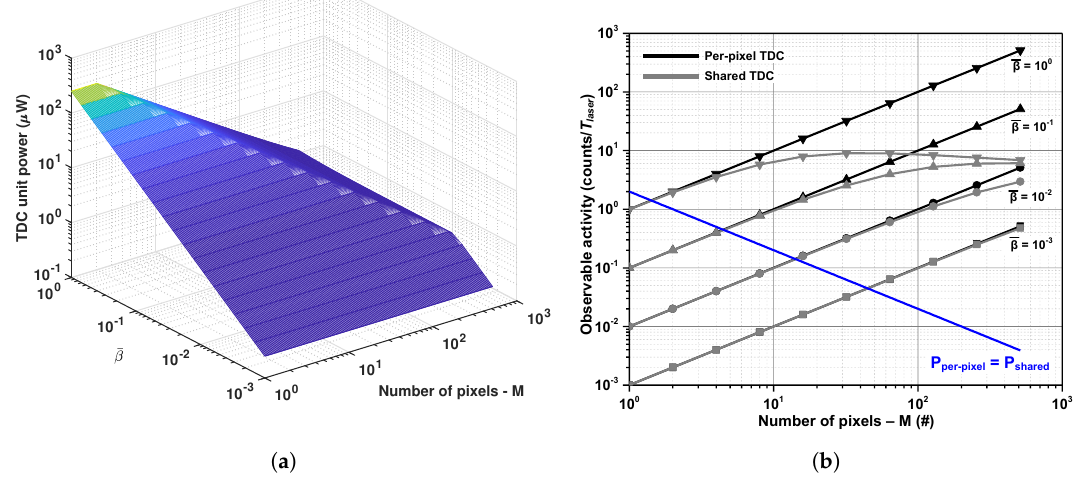
Figure 3. Relationship between power consumption, activity, and number of pixels. ( a ) Average power per TDC unit; ( b ) β compression due to combination dead time, within a laser pulse ( T laser ) of 5ns. Conditions above the blue line makes it more power-efficient to share a TDC instead of using a single TDC per